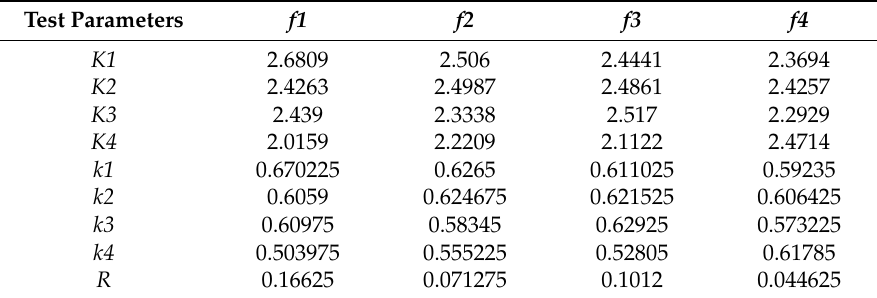
Table 5. Results of the extreme difference